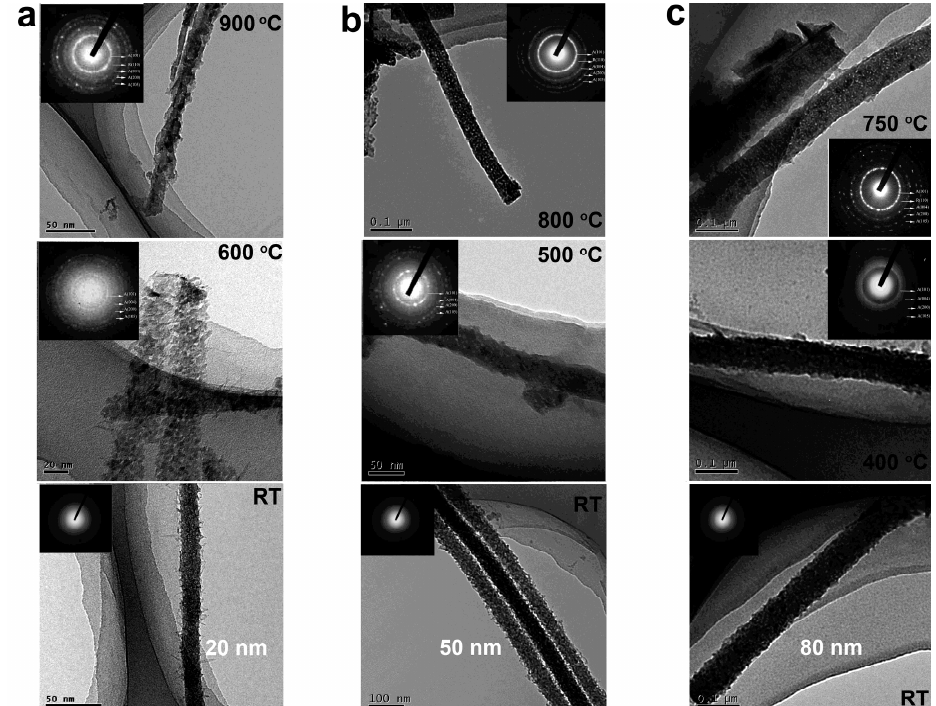
Figure 9. Typical transmission electron microscopy (TEM) images of the as-prepared and annealed TiO 2 nanowires with diameters of ( a ) 20; ( b ) 50; and ( c ) 80 nm. The insets show corresponding selected area electron diffraction (SAED) patterns (Reproduced with permission from [16], Copyright Springer, 2012).